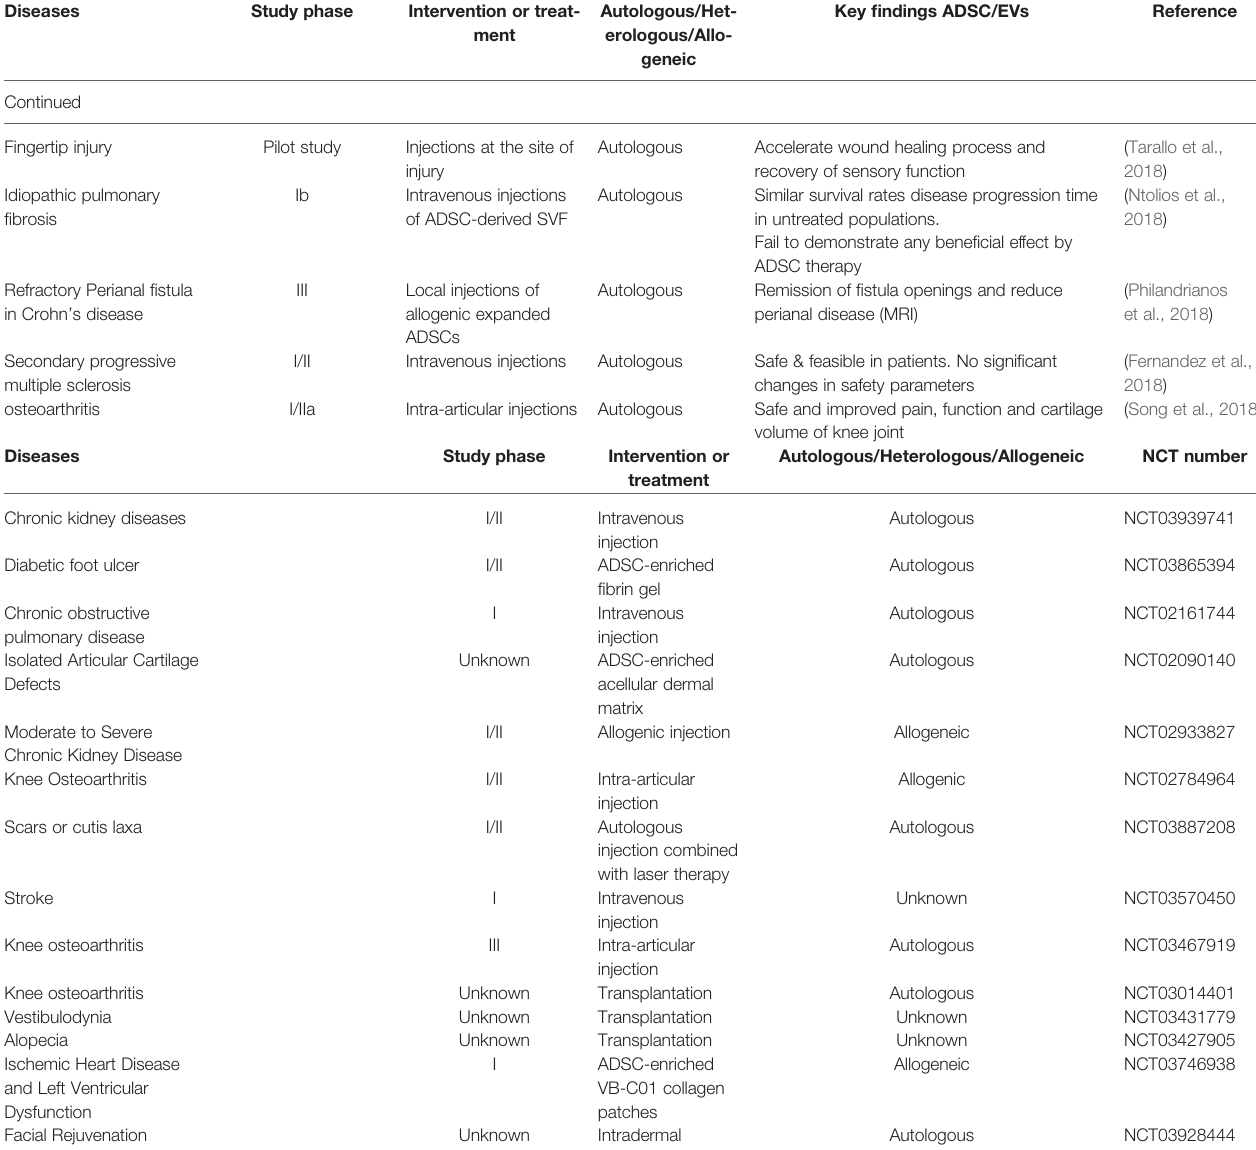
TABLE 3 | Completed and ongoing clinical trials of